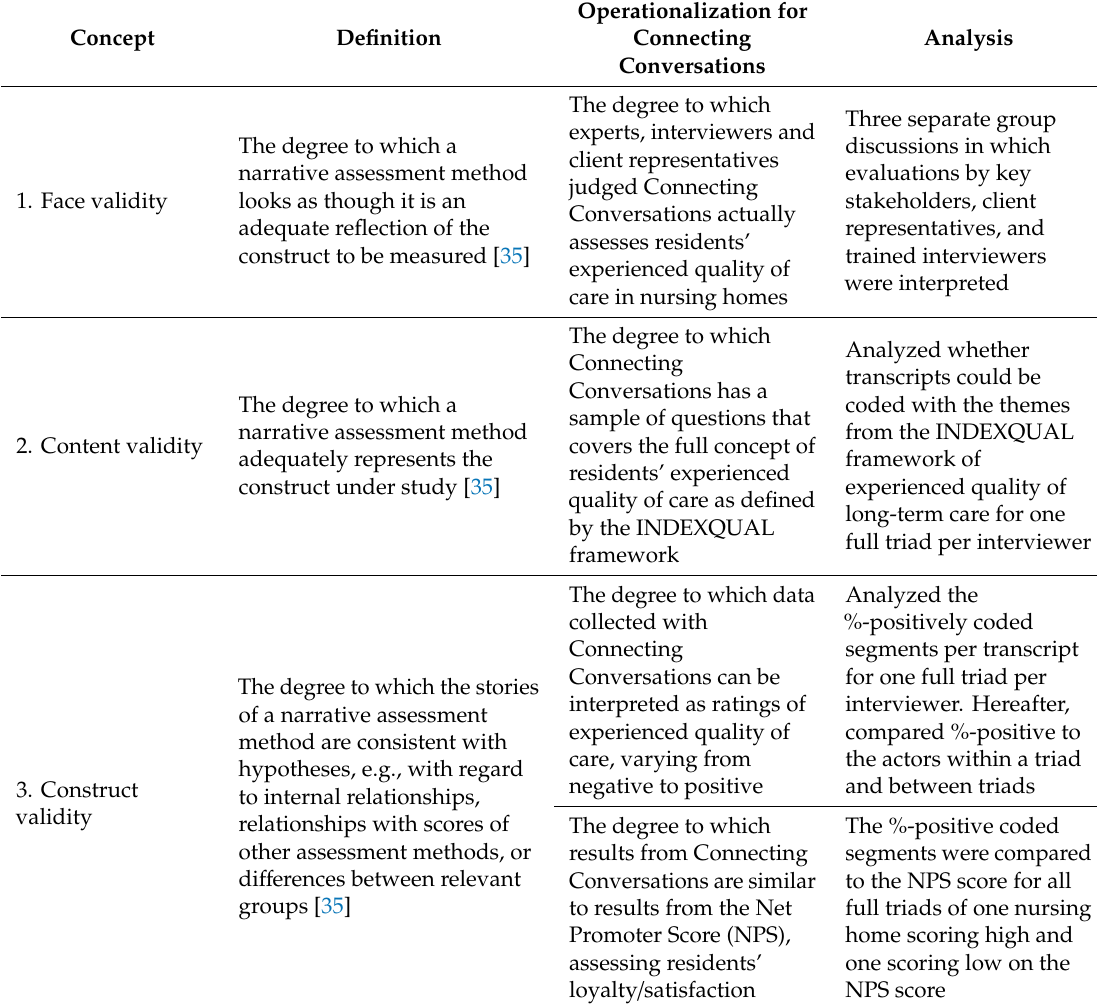
Table 1. Validity definitions, operationalization, and analyses for Connecting